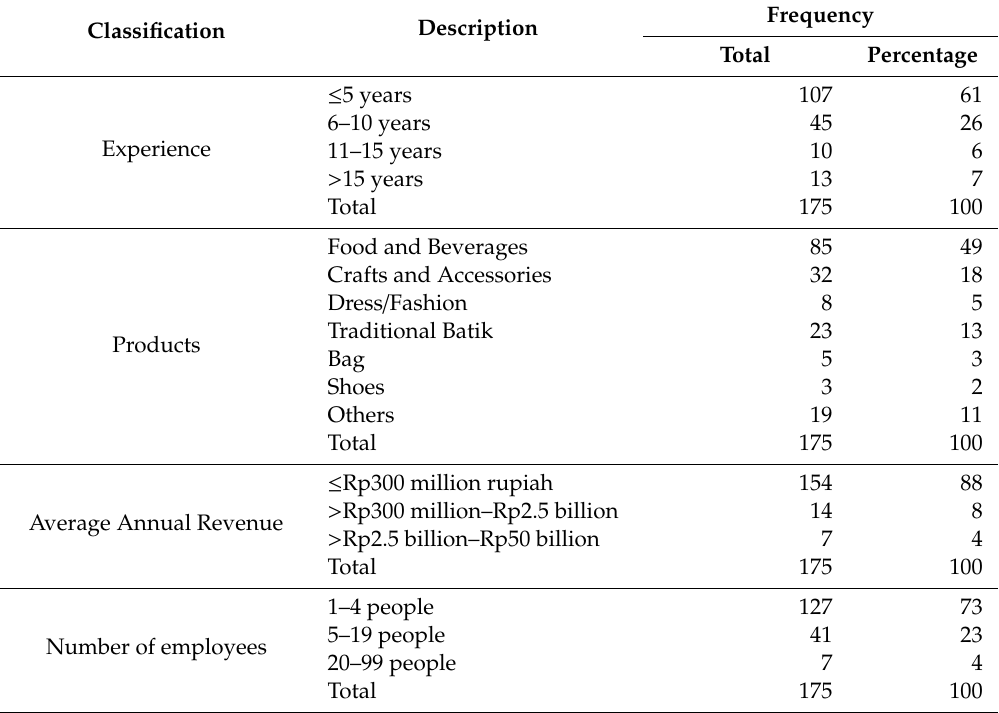
Table 1. Characteristics of